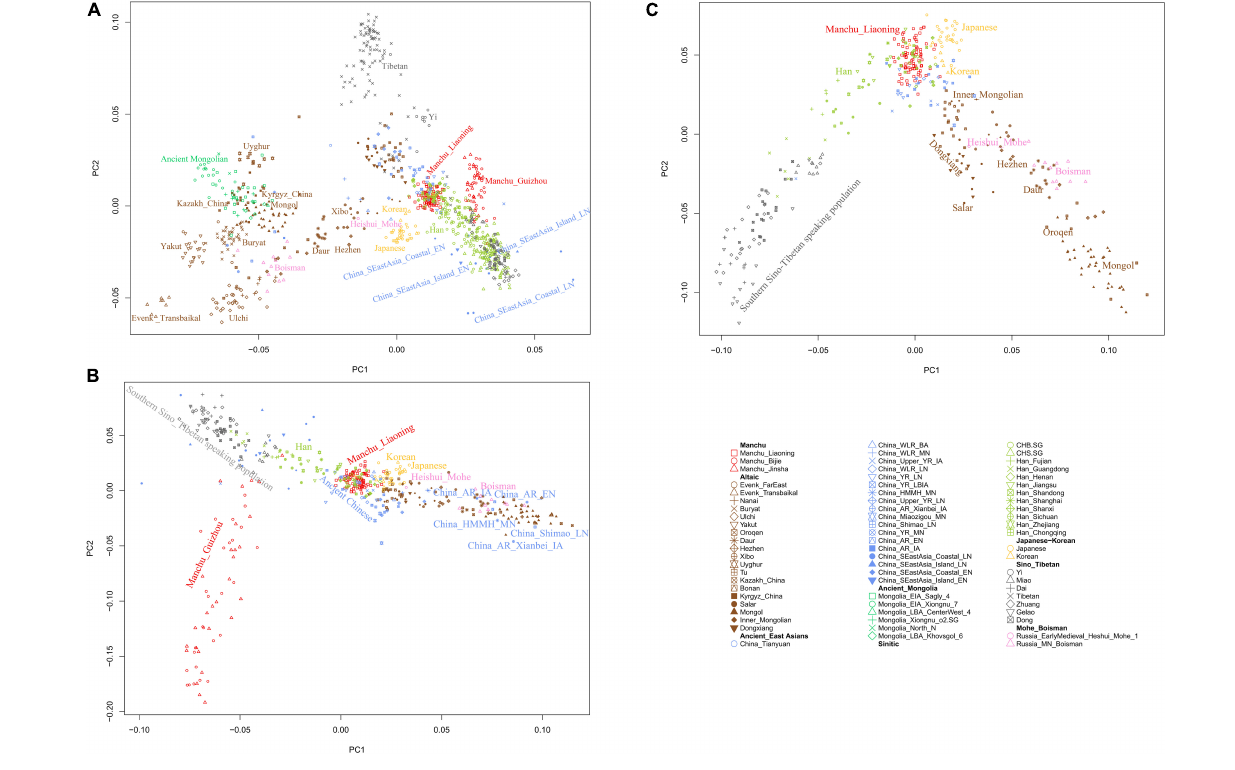
FIGURE 2 | Patterns of genetic relationship among East Asian populations and Liaoning Manchus inferred from the principal component analysis (A–C) . Modern populations were color-coded on the basis of their language family categories, and different shapes represented different populations. All ancient populations were projected onto